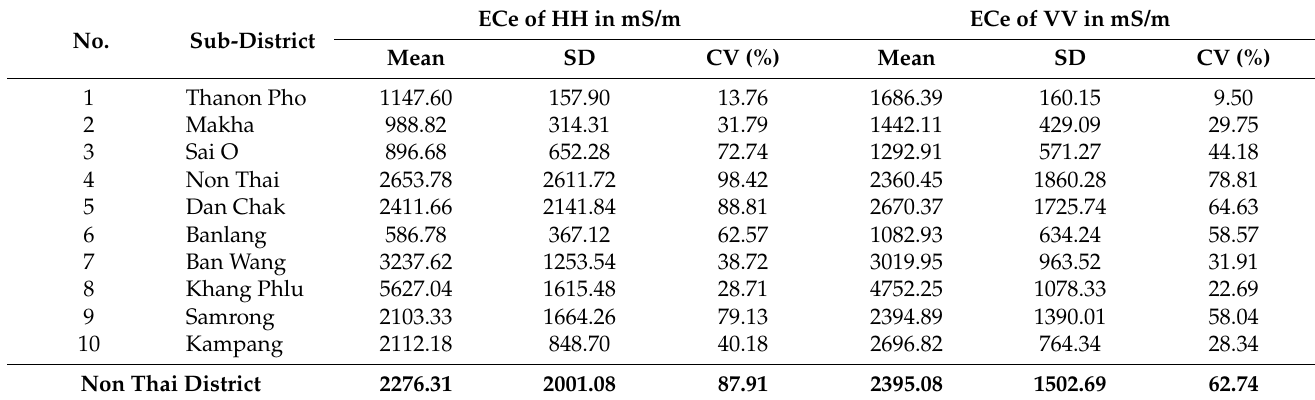
Table 8. Statistical data of soil salinity prediction with ECe data using IDW of two modes by sub-district.